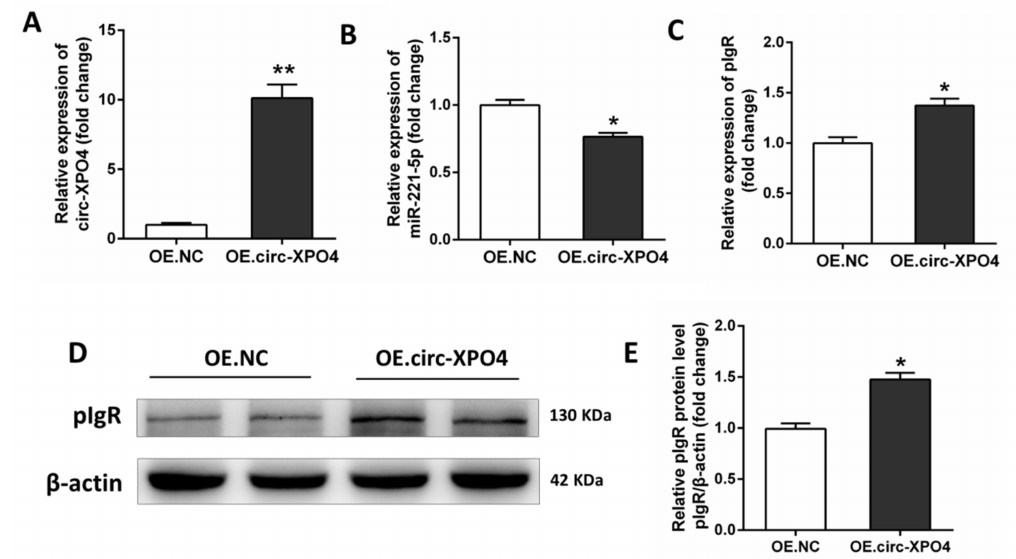
Figure 6. PM-sEVs circ-XPO4 regulates the miR-221-5p/pIgR pathway in IPEC-J2 cells. ( A – C ) qRT-PCR analysis of circ- XPO4, miR-221-5p, and pIgR expression levels in IPEC-J2 cell treated with OE.NC or OE.circ-XPO4 ( n = 6). ( D , E ) Western Blotting analysis of pIgR protein levels in IPEC-J2 cell treated with OE.NC or OE.circ-XPO4 ( n = 4). * p < 0.05; ** p <